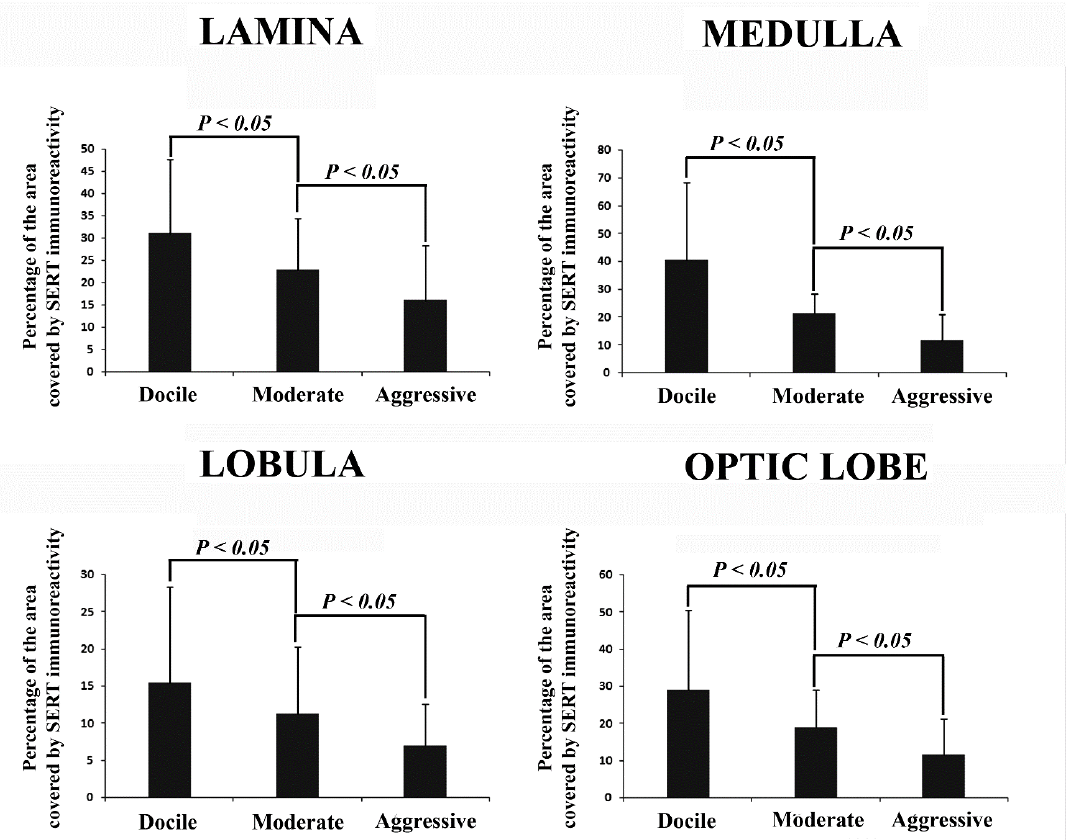
Figure 3. Histograms showing the mean percentages of the image covered by SERT immunoreactivity ± standard deviation (SD) in the lamina, medulla and lobula and in the optic lobe as a complex for docile, moderate and aggressive honeybees.